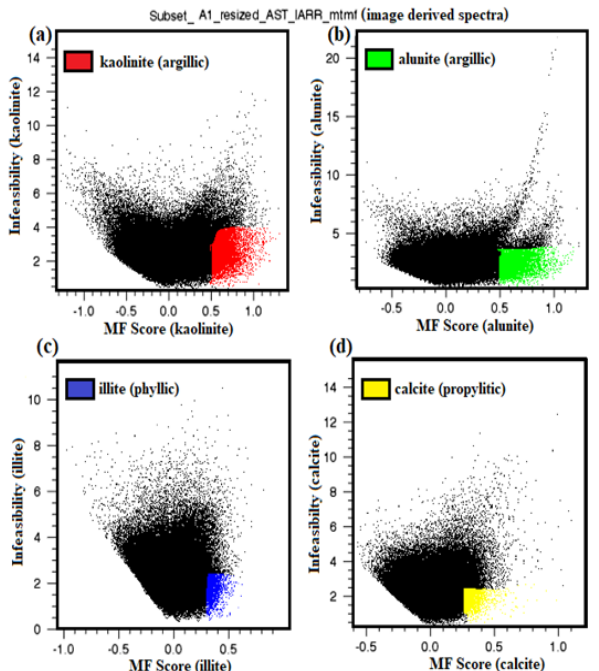
Figure 4 : 2-Dimensional scatter plots used to map valid alteration detections (A) for 4 endmembers (ASTER endmember spectra) as reference